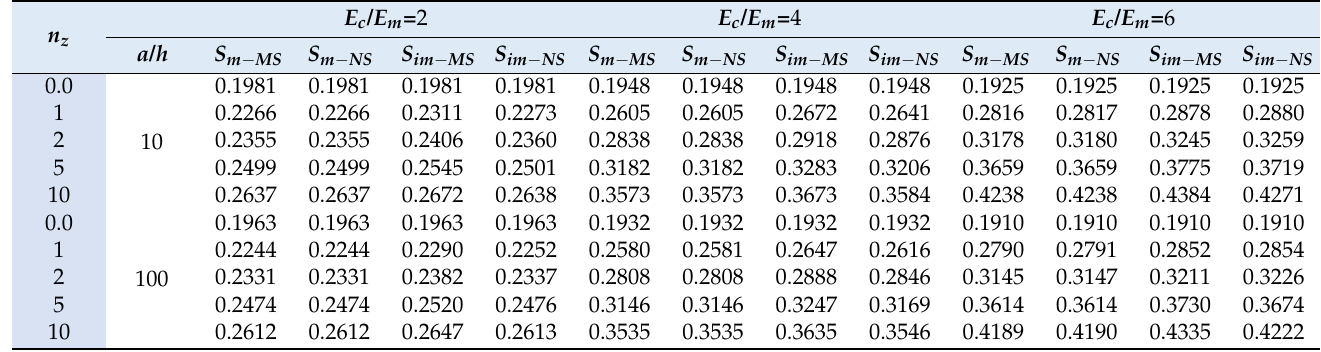
Influence of Young’s modulus ratio ( E c / E m ) on the non-dimensional stress (cid:16)